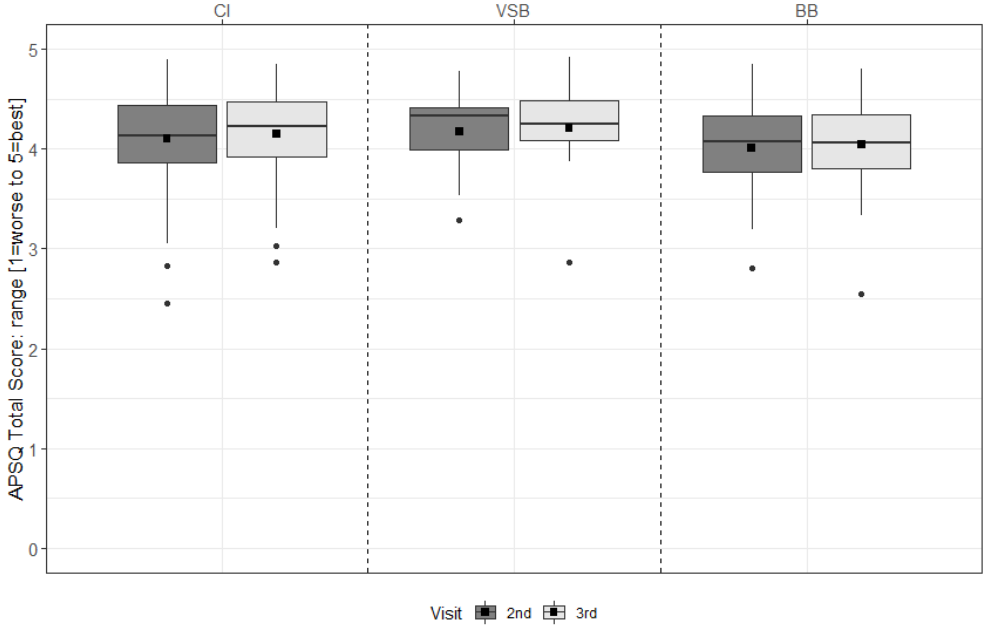
Figure 4. APSQ total scores of the second and the third study visit (6 m and 12 m, respectively) for each group. The mean values are depicted as black squares and the medians as horizontal lines. The black circles represent outliers. Higher scores indicate more satisfaction. CI = cochlear implant, VSB = VIBRANT SOUNDBRIDGE, and BB = BONEBRIDGE .